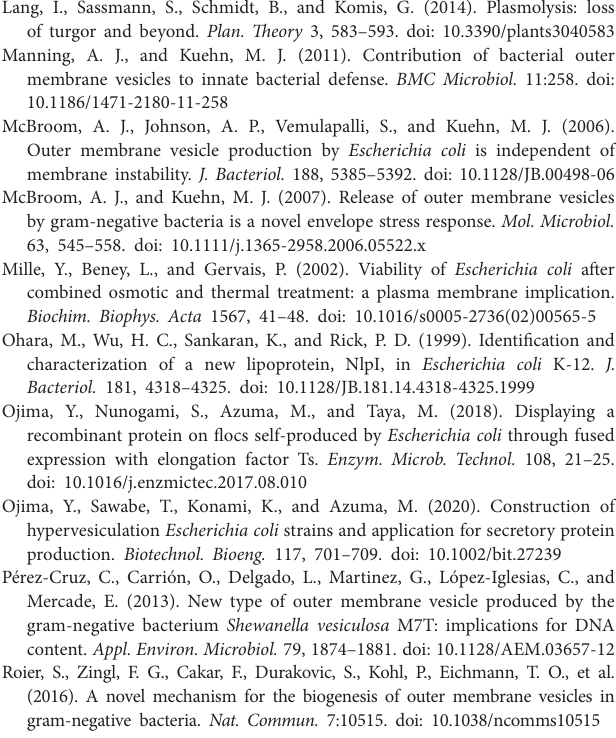
Supplementary Figure S1 | Distribution of cell volumes in each E. coli strain. The cells were harvested after 24 h in culture. Cell volume was determined using qNano. Supplementary Figure S2 | CLSM images of OMV samples isolated from the WT (A) and Δ mlaE Δ nlpI (B) strains. The fluorescence levels of OMV in the WT and mutant strains were adjusted to the same